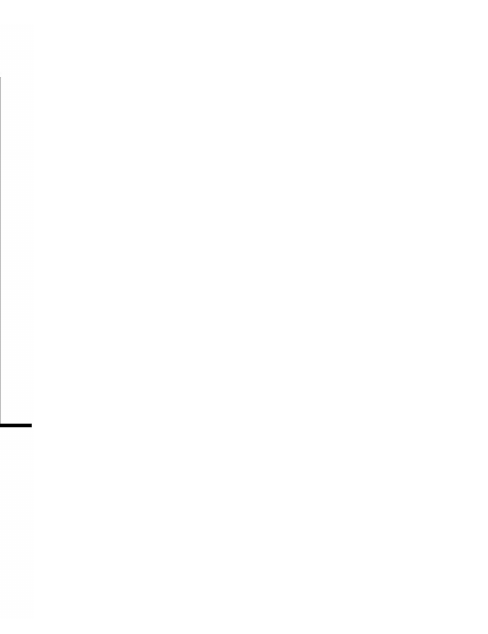
Figure 2. Cell viability of HK-2 cells following a 24-h treatment with 0.1 mM polymyxin B, FADDI-251 or FADDI-287, and the control without treatment. Significance: * p ≤ 0.0001; multiple comparison Tukey test.